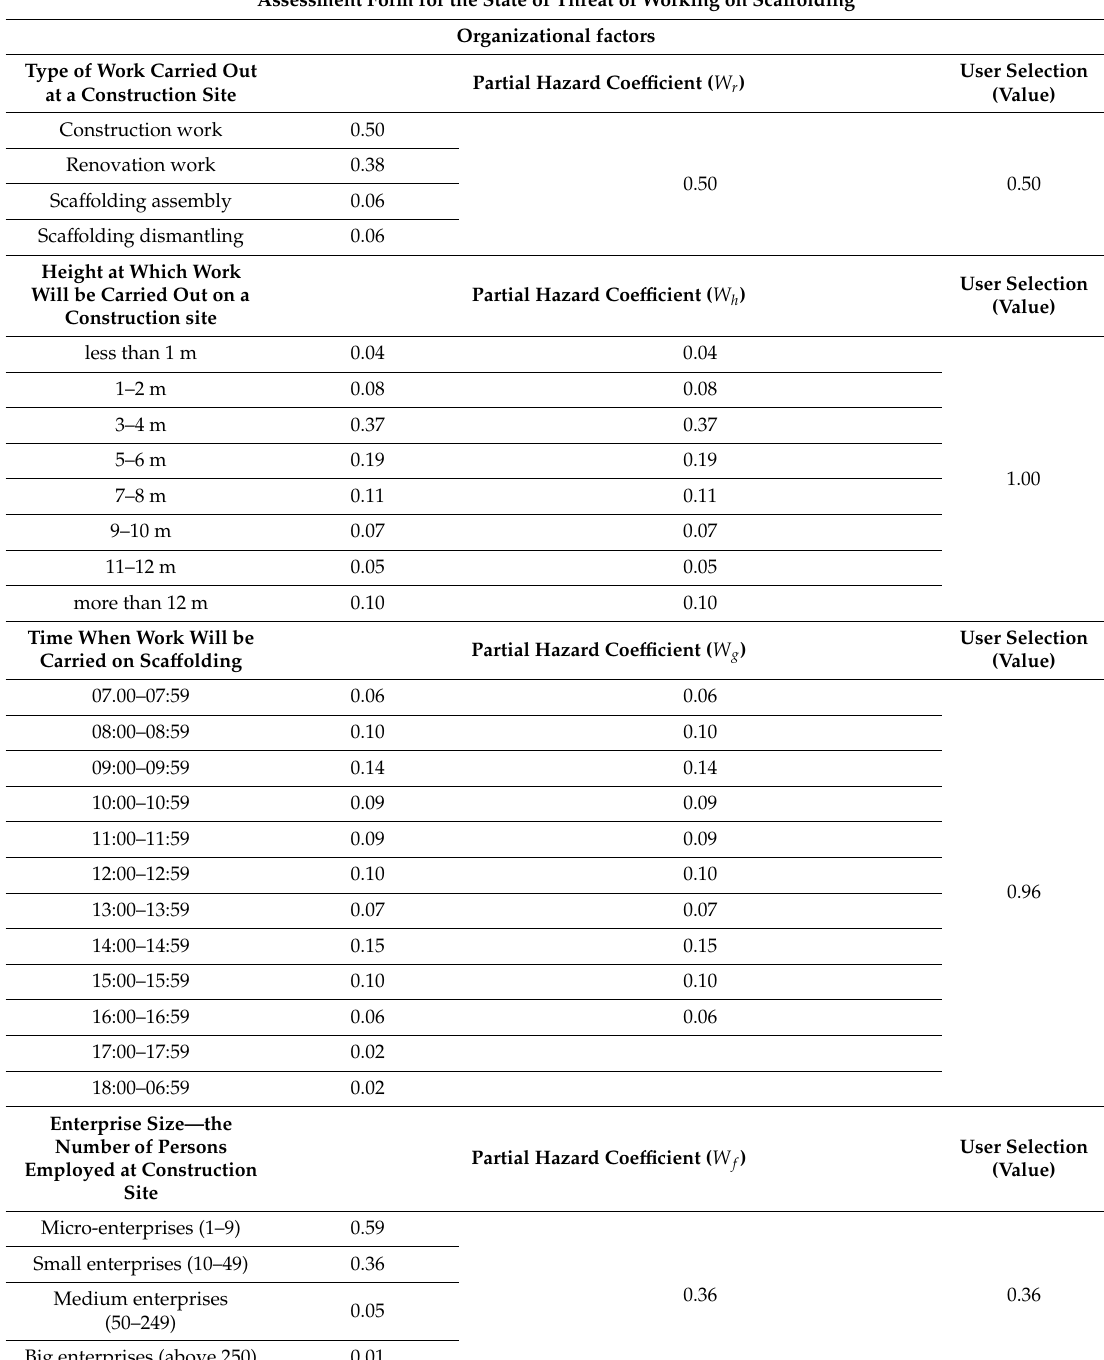
Assessment Form for the State of Threat of Working on Sca ff olding Organizational